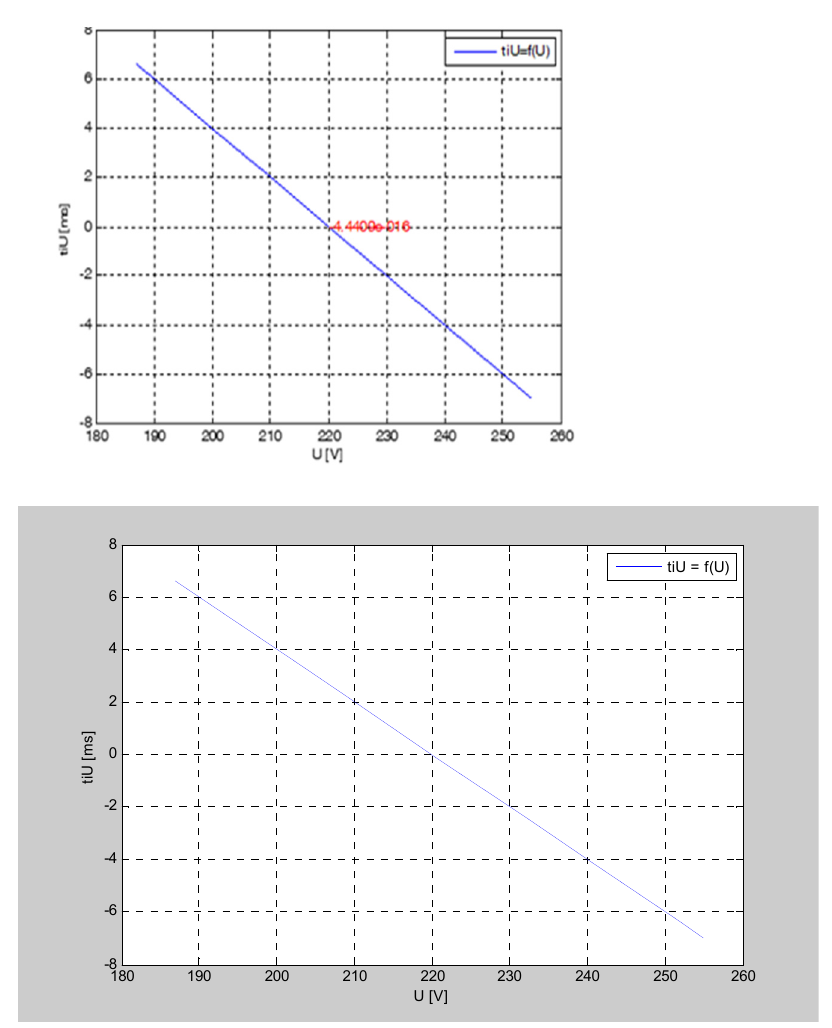
Figure 13. Dependency of t UDC on the DC voltage supply on the disconnection of a circuit breaker. 3.